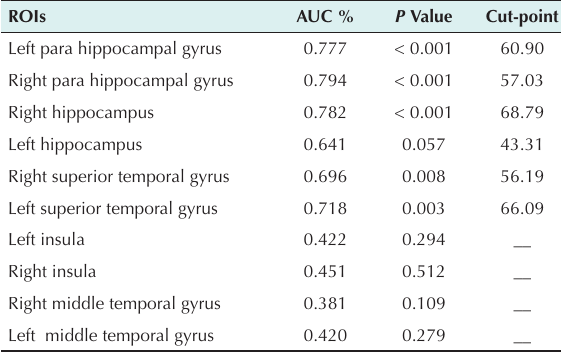
Table 2. Cut-Point and Significant ROIs ROIs AUC % P Value Cut-point Left para hippocampal gyrus 0.777 60.90 Right para hippocampal gyrus 0.794